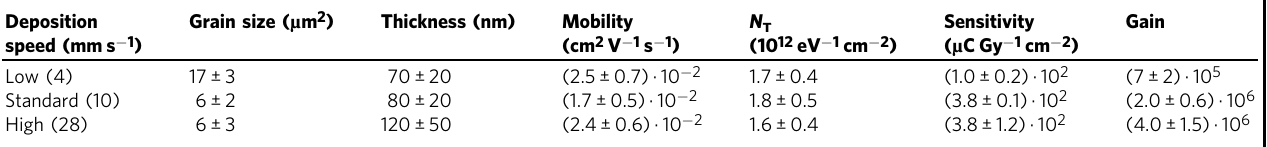
Table 1 Structural, electrical, and detection parameters for different deposition speeds.